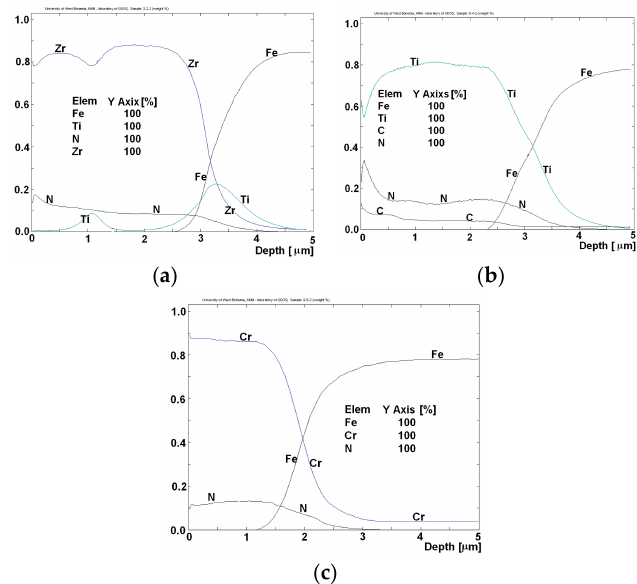
Figure 3. Glow Discharge Optical Emission Spectroscopy (GD-OES) profile concentration analysis of coating: ( a ) ZrN; ( b ) TiCN MP and ( c )